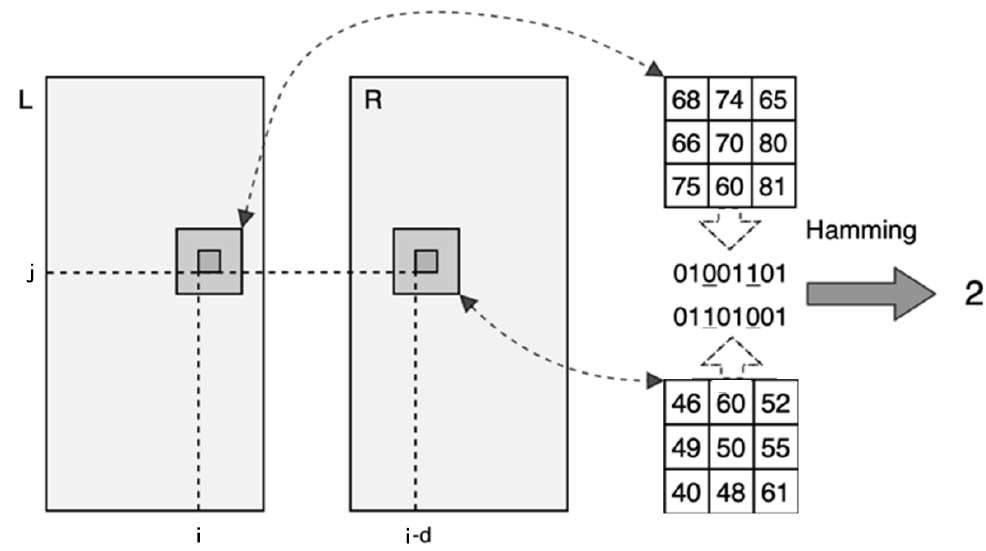
Figure 2. Schematic diagram of the initial matching cost calculation.